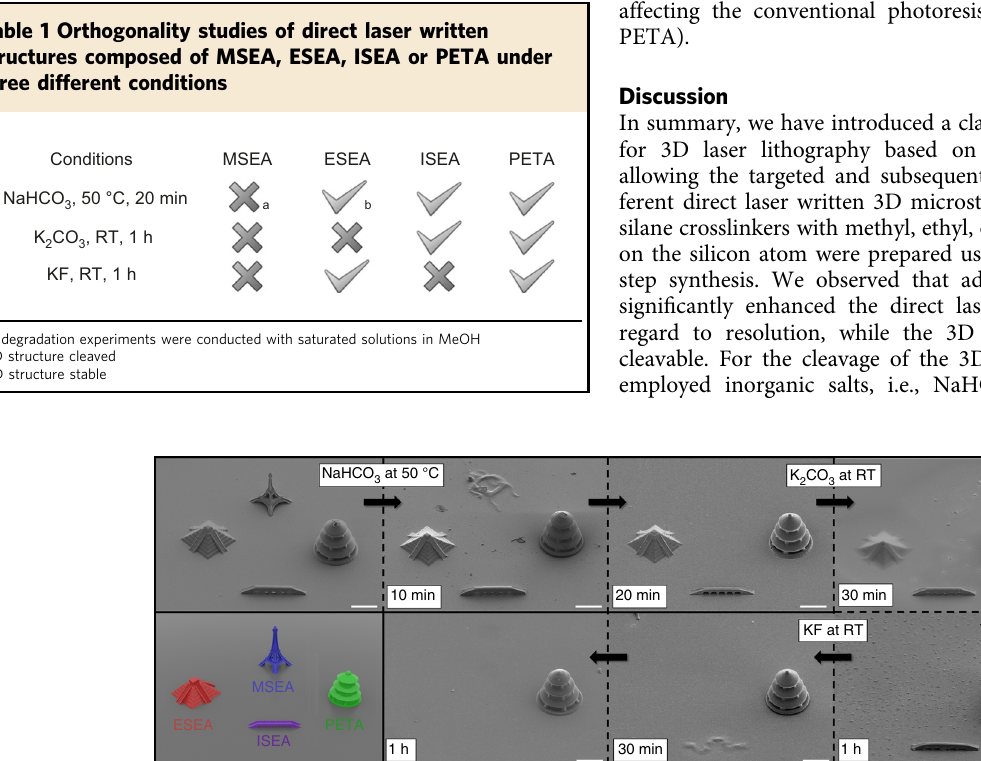
Fig. 3 SEM images showing the selective cleavage of MSEA-, ESEA-, and ISEA-based 3D microstructures. The glass substrate was sequentially immersed in NaHCO 3 at 50 °C, then, in K 2 CO 3 at RT and fi nally, in KF at RT (scale bars = 20 μ m). (Bottom left) Schematic representation of a glass substrate containing four model structures composed of MSEA (blue Eiffel tower), ESEA (red Aztec pyramid), ISEA (purple bridge) and PETA (green Asian